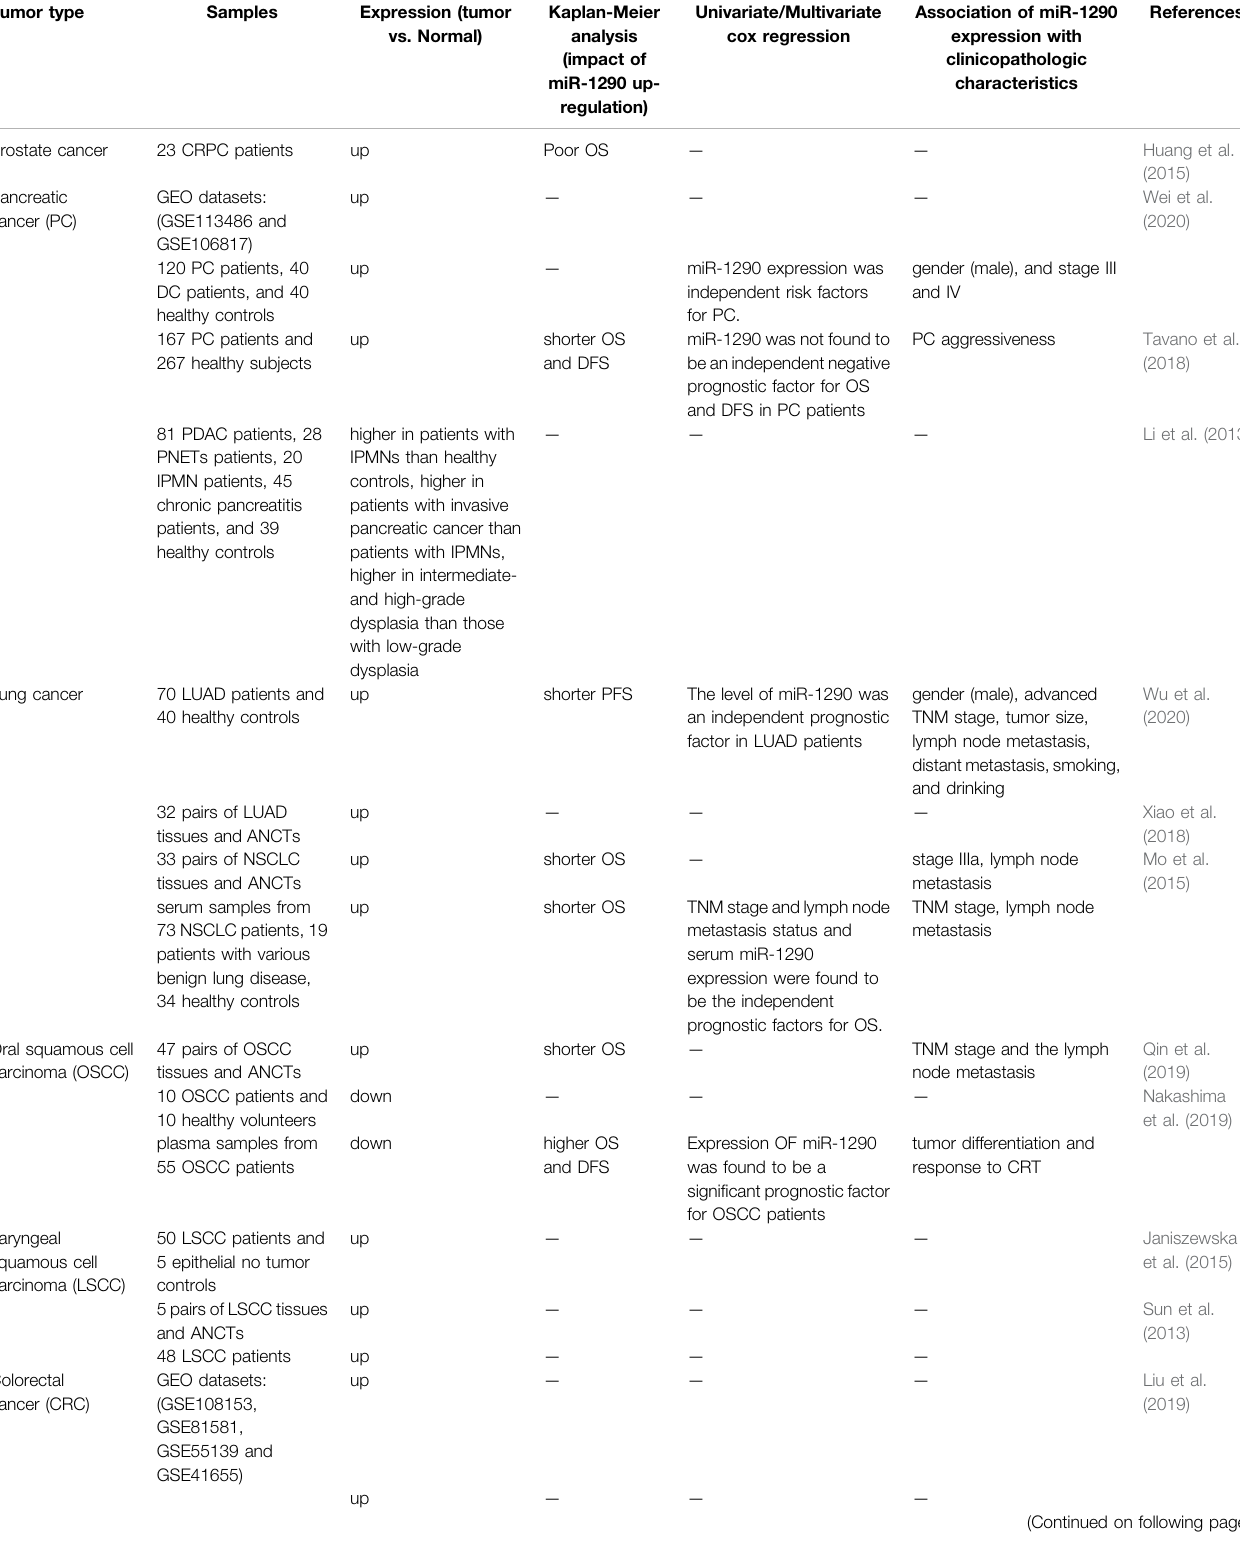
TABLE 3 | Dysregulation of miR-1290 in clinical specimens (DC: benign pancreatic disease controls, PFS: progression free survival, LUAD: Lung adenocarcinoma, ANCTs: adjacent non-cancerous tissues, OS: Overall survival, DFS: disease-free survival, TNM: tumor-node-metastasis, NSCLC: non-small-cell lung cancer, CRA: colorectal adenoma, HGSOC: high grade serous ovarian cancer, EOC: epithelial ovarian cancer, HGSOC: high grade serous ovarian carcinoma.). Tumor